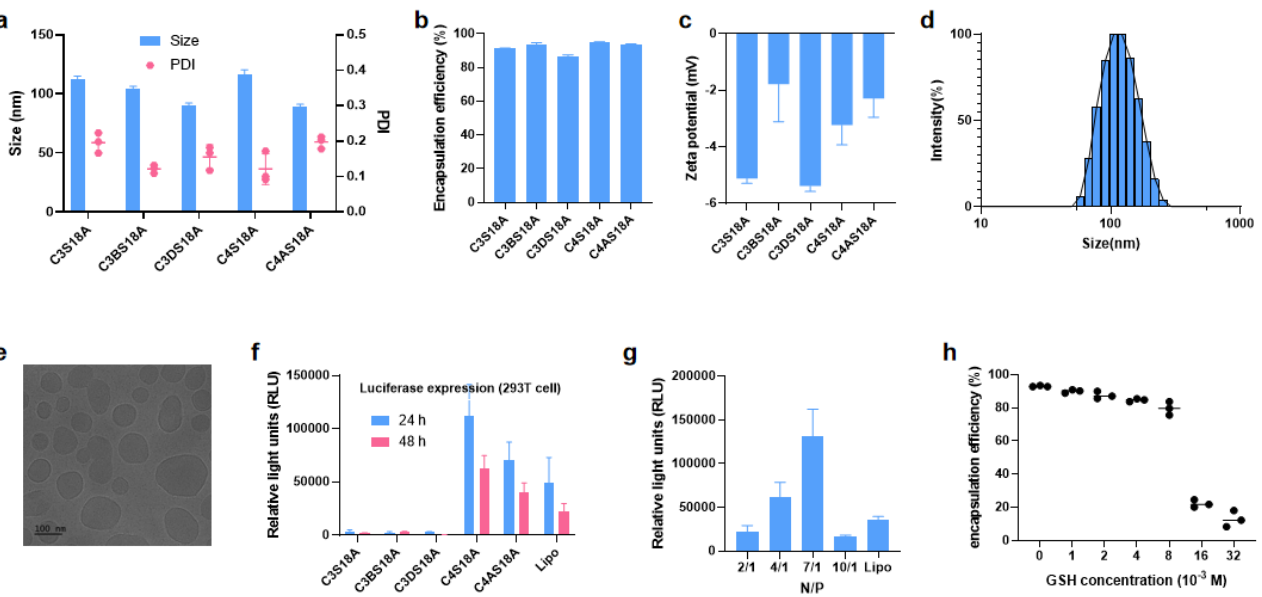
Figure 3. Optimization and characterization of LNPs prepared from leading lipids loaded with Fluc − mRNA. ( a ) Size (nm) and PDI of Luc − mRNA LNPs. ( b ) Zeta potential of Luc − mRNA LNPs. ( c ) Encapsulation efficiency (EE) of different LNPs loaded with Fluc − mRNA. ( d ) Size distribution by the intensity of C4S18A-derived LNP. ( e ) Cryo-electron microscopy of C4S18A LNP. ( f ) Luciferase expression following treatment of 293T cells with Fluc − mRNA LNPs. ( g ) Optimization of N/P ratio using the best C4S18A LNPs. ( h ) EE change over the concentration of GSH (from 0 to 32 × 10 − 3 M). Data presented as mean ± SEM of 3 separate samples or experiments.